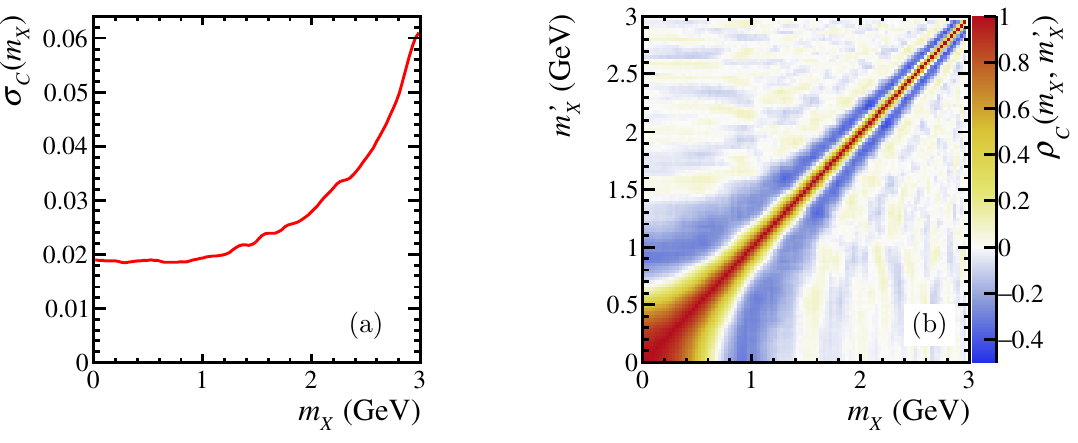
Figure 9 . (a) Statistical uncertainty (cid:27) C ( m X ) and (b) correlation function (cid:26) C ( m X ; m 0 coe(cid:14)cient for the sample of 10 4 B 0